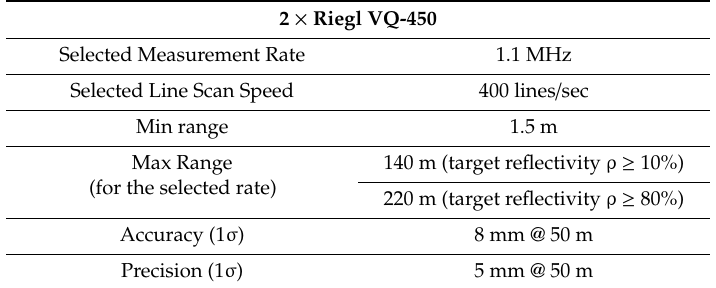
Table 1. Technical data of mobile laser scanning system (MLS) Riegl VMX ® 450.